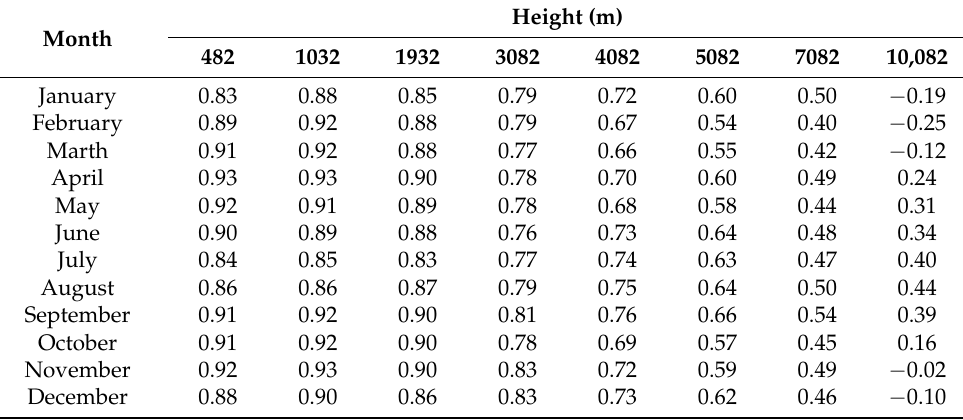
Table A4. Correlation coefficients between zenith wet delay and water vapor pressure of Jiamusi station at different heights and